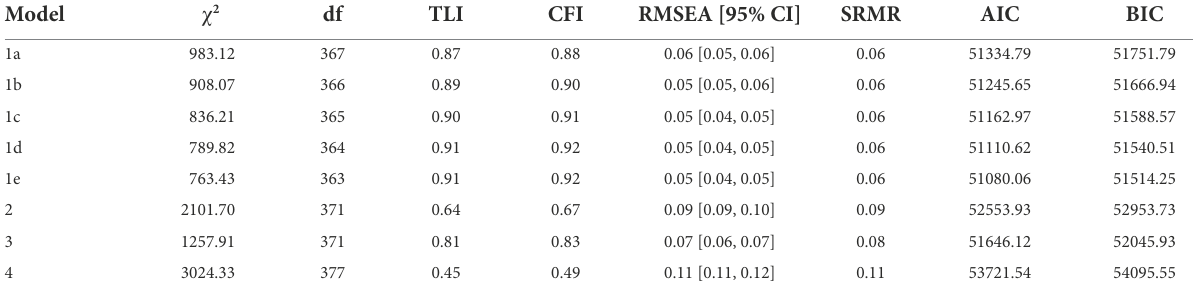
TABLE 2 Goodness-of-fit statistics of competing measurement models. Model